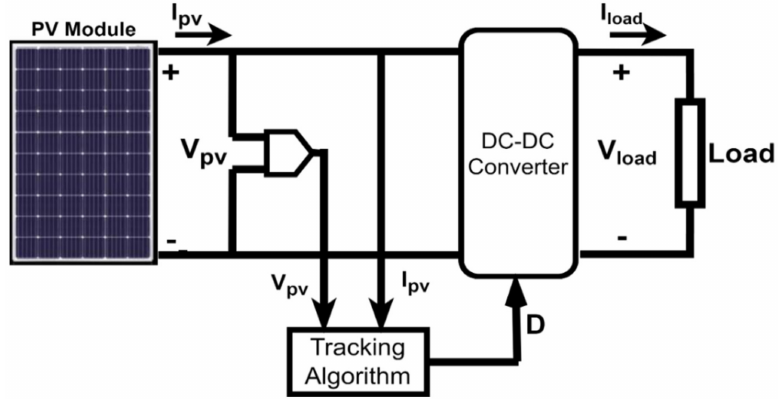
Figure 6. DC–DC convertor with P-V